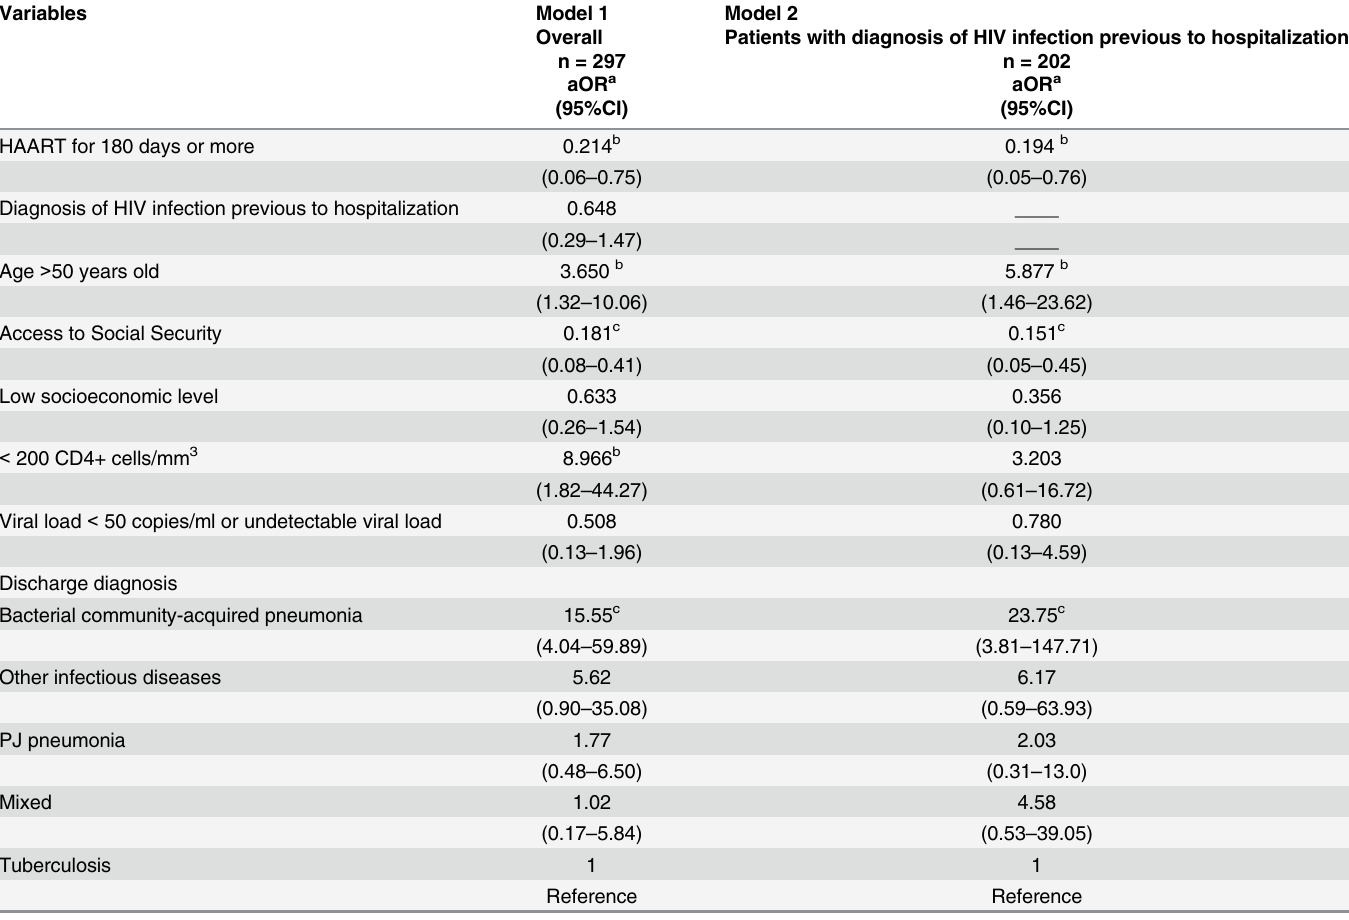
Table 5. Association between all-cause in-hospital mortality and selected variables in HIV/AIDS patients admitted into a specialty hospital for respiratory diseases in Mexico City from January 2010 to December